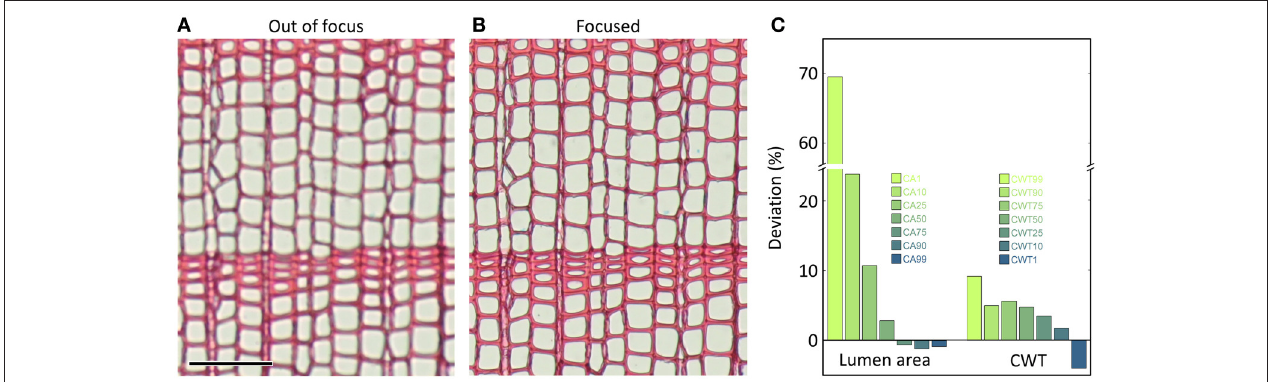
FIGURE 7 | The same anatomical microslide of Pinus sylvestris once captured (A) out of focus and (B) with optimal focus (only subset images shown). The entire images were analyzed with the image-analysis tool ROXAS (cf. Table 1 ) using always the same settings. In the out-of-focus image, 178 small tracheids out of totally 4240 (4.2%) were not detected, because lumina of very narrow tracheids were insufficiently defined. Accordingly, the lumen area corresponding to the smallest 1% of the measured values (CA1) were 69% larger in the poorly-focused than the well-focused image, while in the largest tracheids (CA99) the lumina appeared 1% smaller in the poorly-focused images (C) . Similarly, the thickest tangential cell walls (CWT99, corresponding to the very small tracheids) were overestimated by 9% in the poorly-focused compared to the well-focused image, while they were underestimated by 4% toward the thinnest walls (CWT1). Scale bar = 100 µ m.